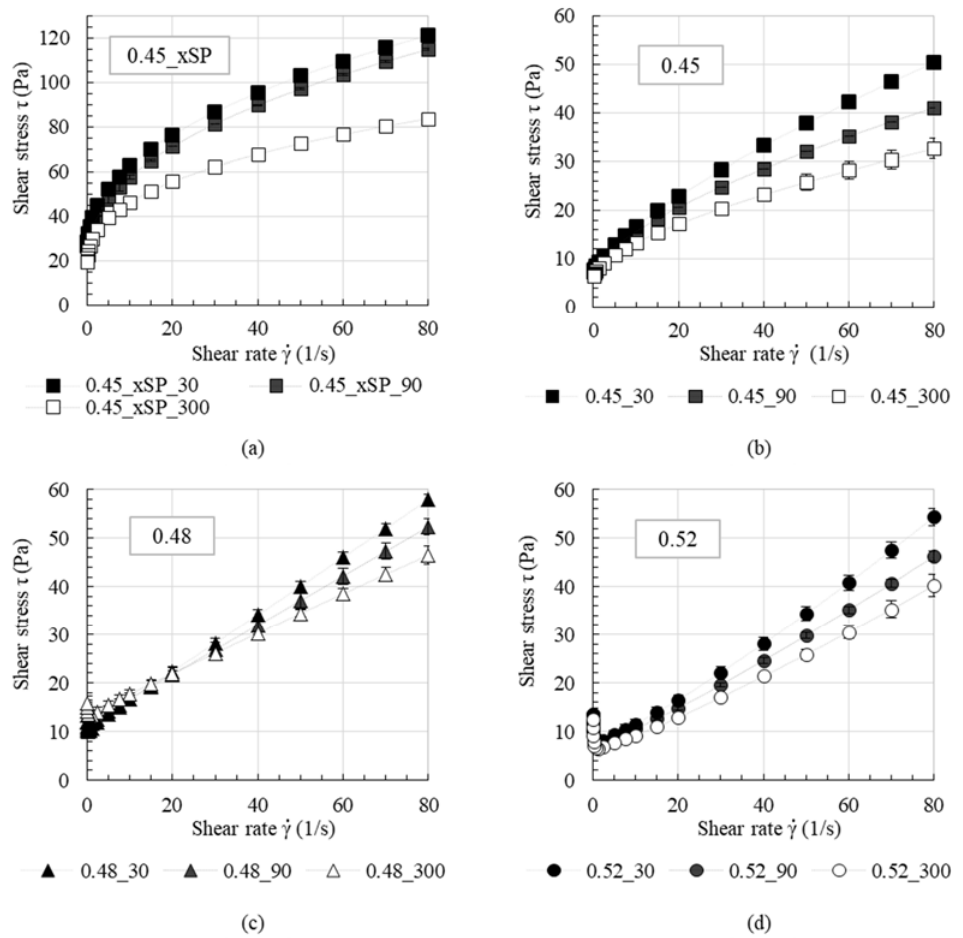
Figure 7. Flow curves of series 0.45_xSP ( a ), 0.45 ( b ), 0.48 ( c ) and 0.52 ( d ) as a function of pre-shear time.